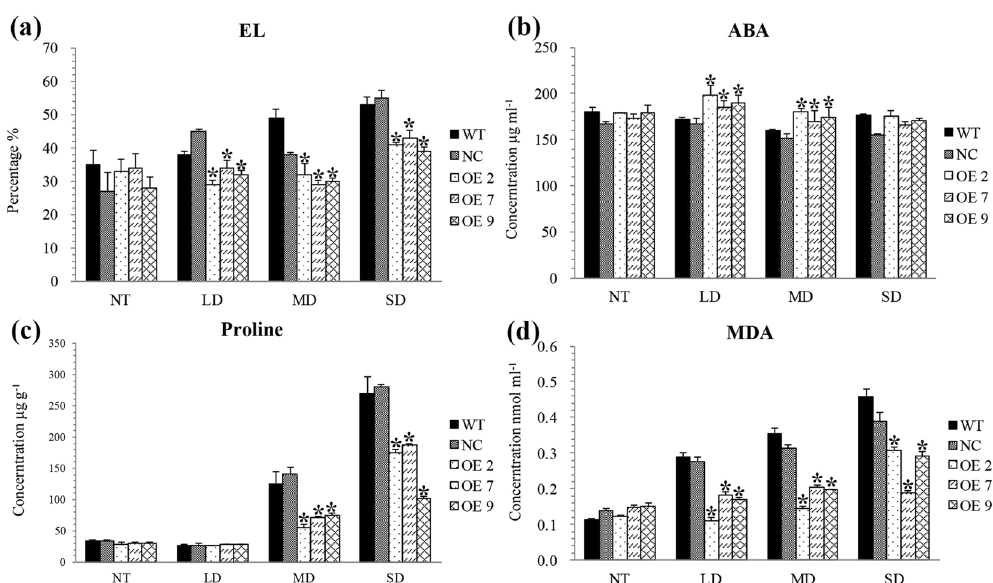
Figure 7. Electrolyte leakage (EL) activities, abscisic acid (ABA), Proline and malondialdehyde (MDA) content in 35 S::N41 (OE), wild type (WT) and NC (negative control) tobacco plants during increasing levels of drought stress, NT (non-treatment), LD (light drought), MD (medium drought), and SD (severe drought). Errors bars represented ± SD (standard deviations). * Indicated a significant difference when compared to WT (Duncan’s multiple range test p <